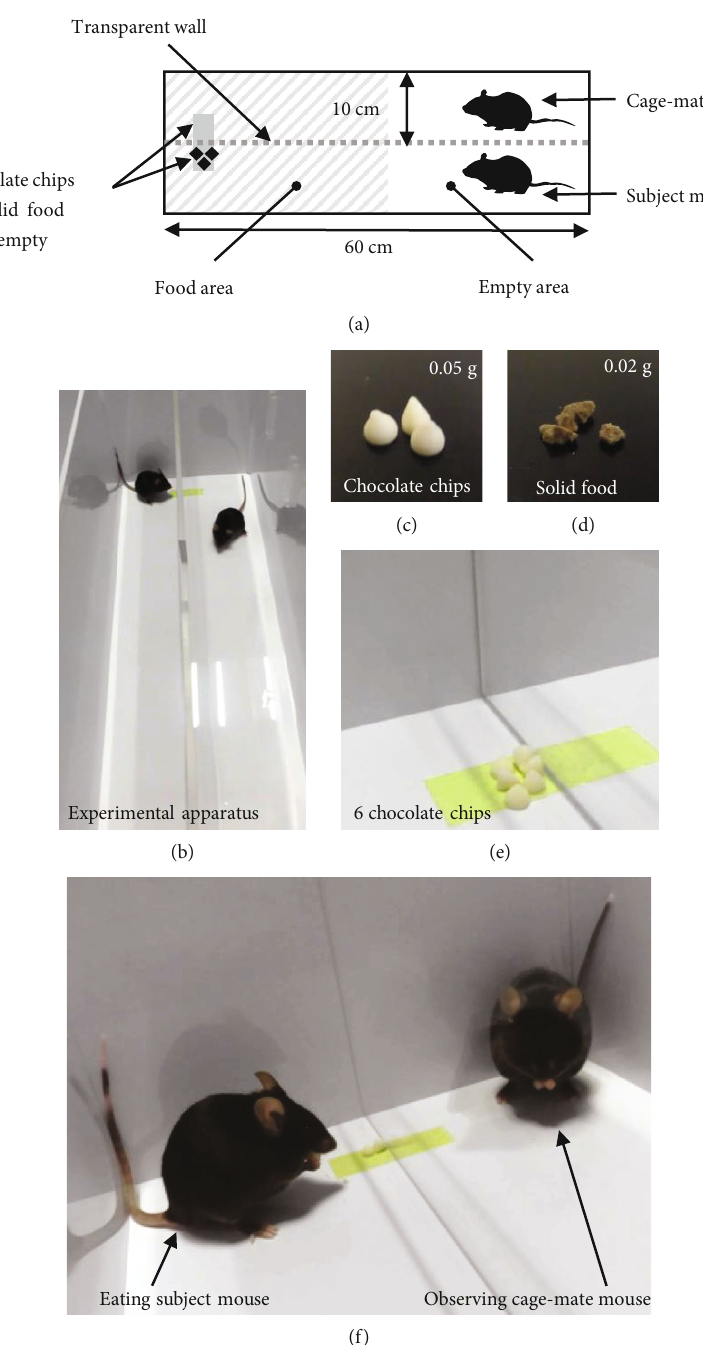
Figure 5: Testing apparatus of the feeding behavioral test. (a) Schematic diagram of the feeding behavioral test. Two mice were placed at the end of the lane simultaneously. The rewards were placed on the opposite side of the lanes. (b) Sample picture during the feeding behavioral test. The test mouse freely moved in the lane. (c) A sample image of the chocolate chips as a high-appeal reward, 0.05g per unit. (d) A sample image of the ordinary crushed solid food as a low-appeal reward, 0.02g per unit. (e) A sample picture of the 6 chocolate chips in the testing apparatus. (f) A sample picture of the feeding behavioral test. Subject mice and cage-mate mice were separated by transparent acrylic